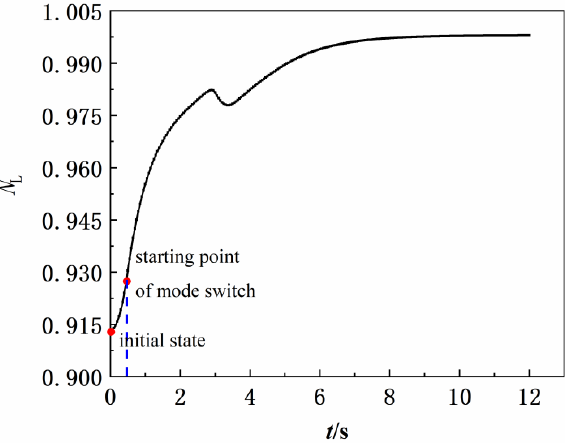
Figure 18. Change curve of low-pressure rotor speed of working-mode switching from double bypass to single bypass at H = 11 km, Ma = 1.2.